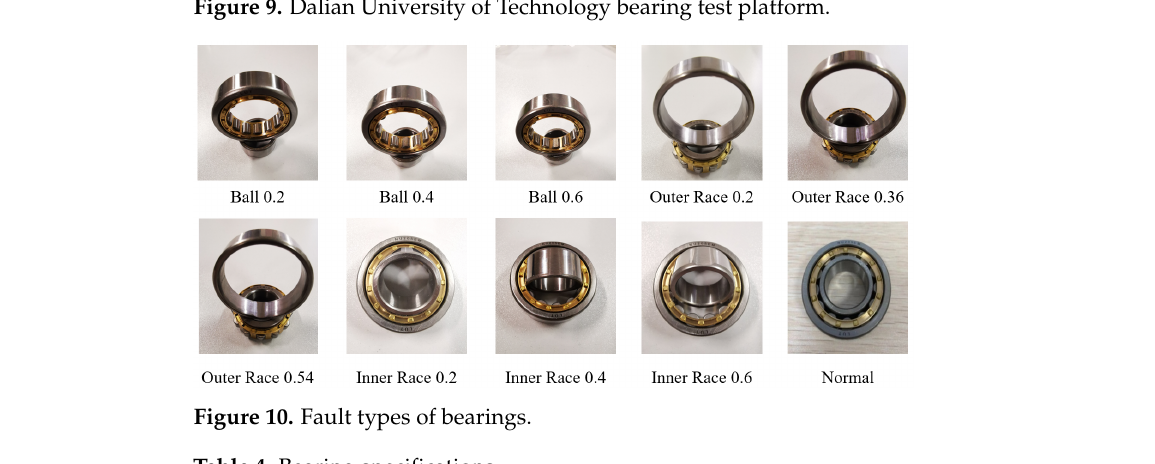
Figure 9. Dalian University of Technology bearing test platform.